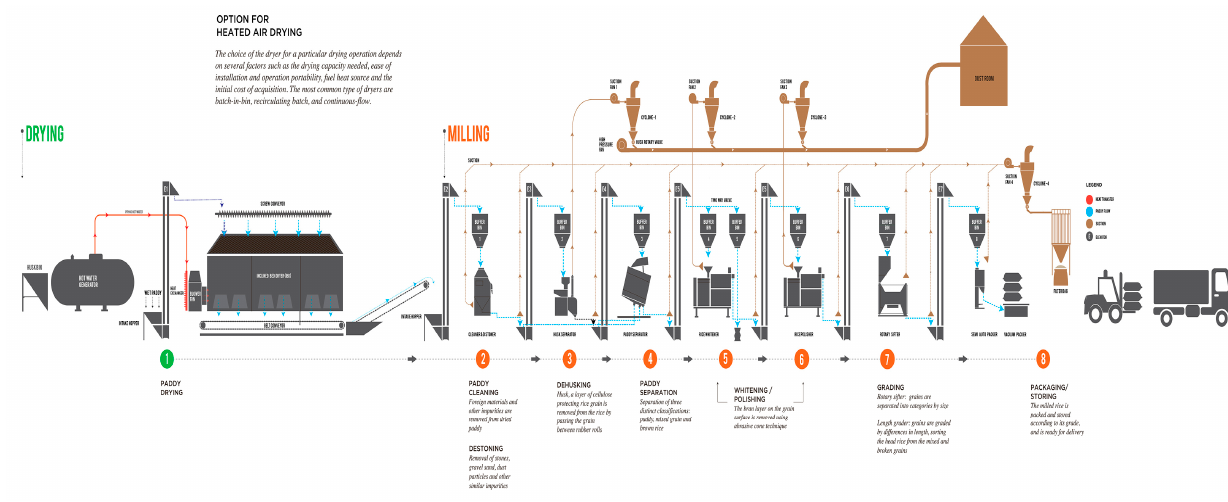
Figure 5. Rice milling process of rice